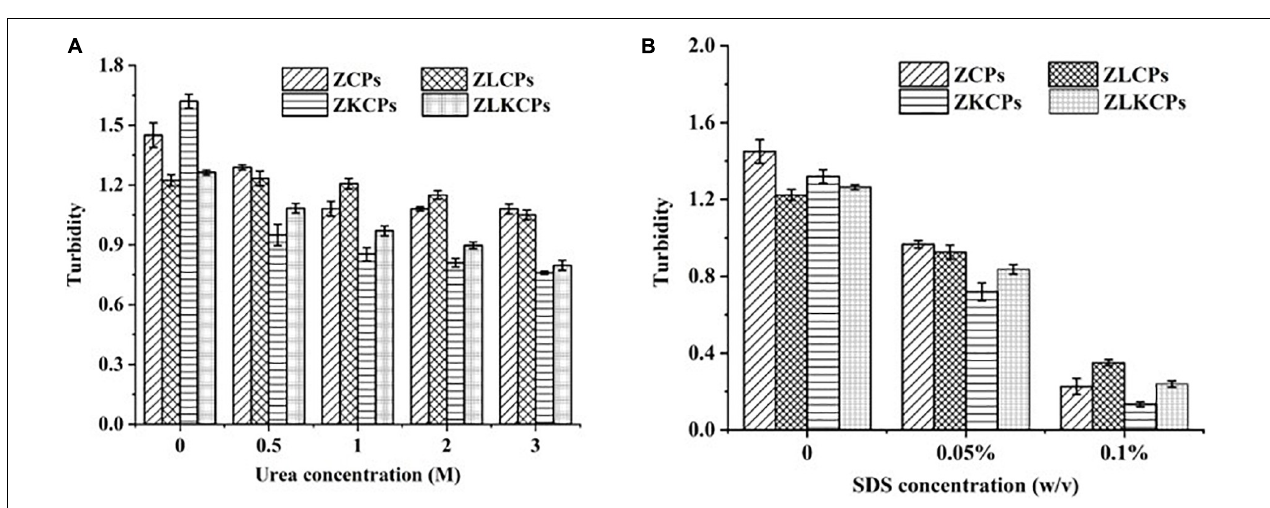
FIGURE 6 | The adsorbed protein (A) and interfacial tension (B) of different samples.